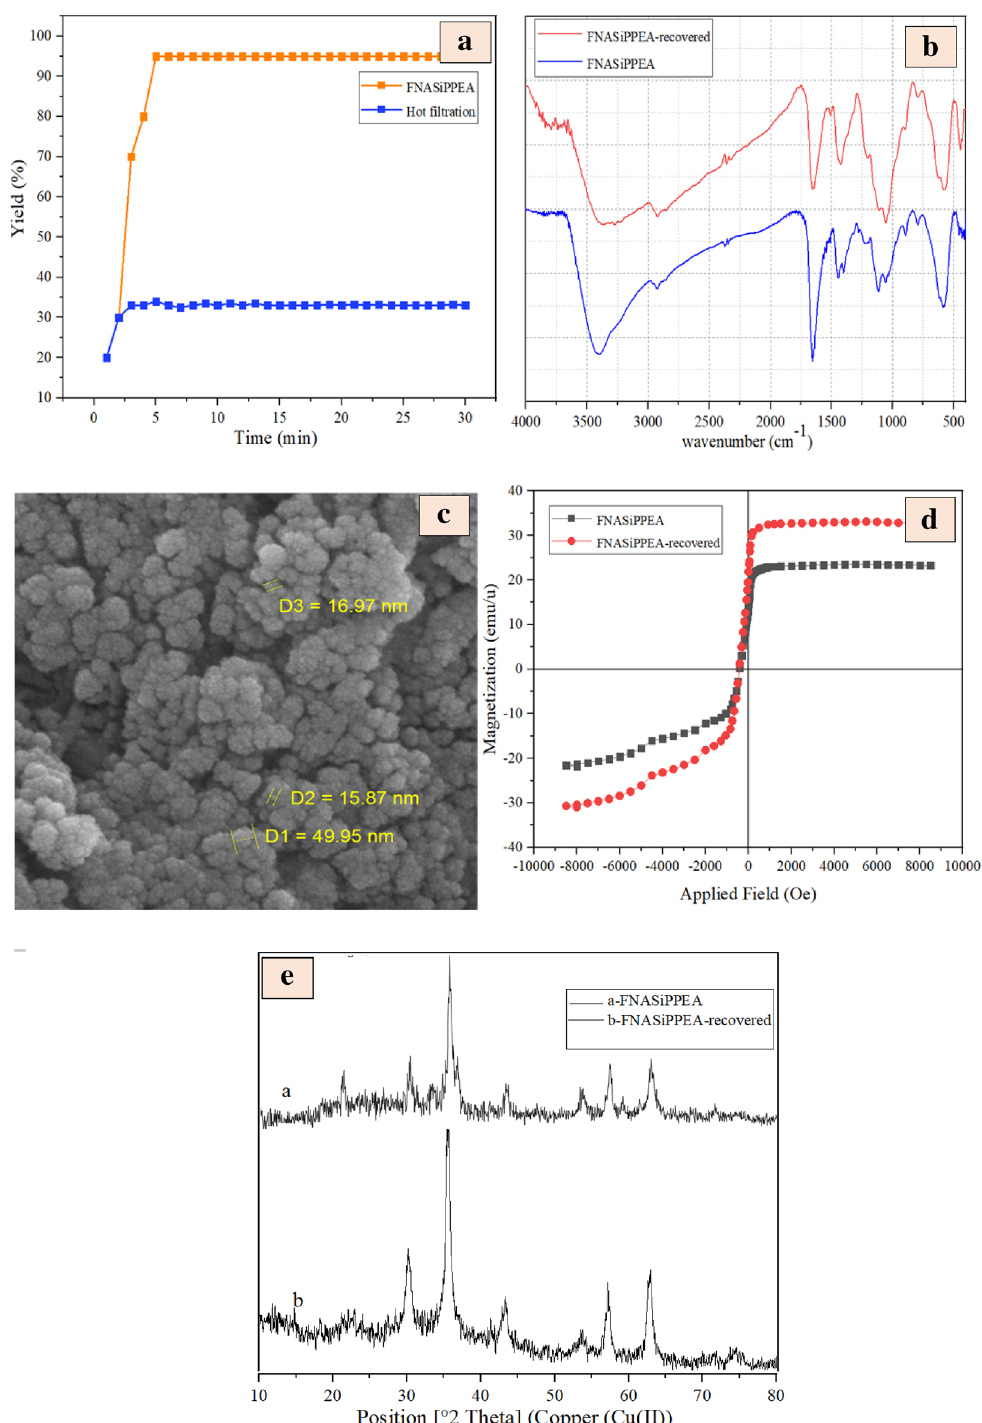
Figure 10. ( a ) Hot filtration test, ( b ) FT-IR, ( c ) FESEM, ( d ) VSM, and ( e ) XRD of recovered bio-based nano-